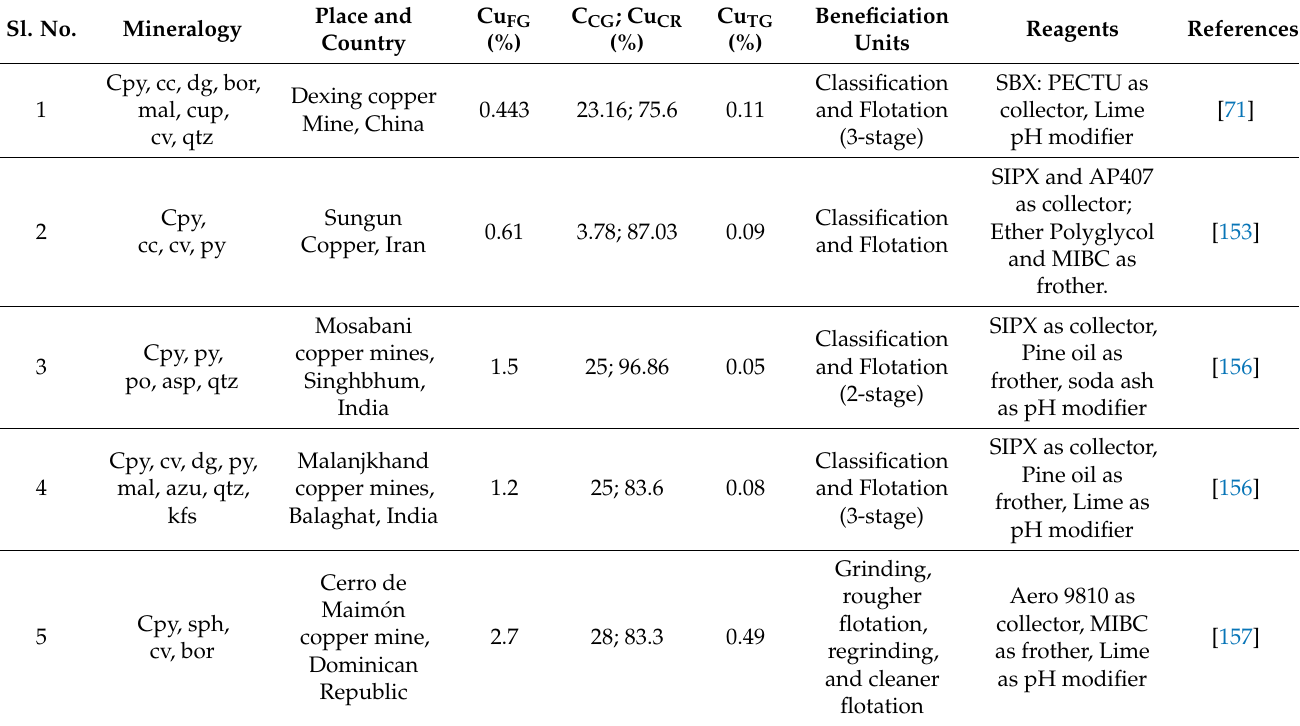
Table 12. Summary of the copper plant flow